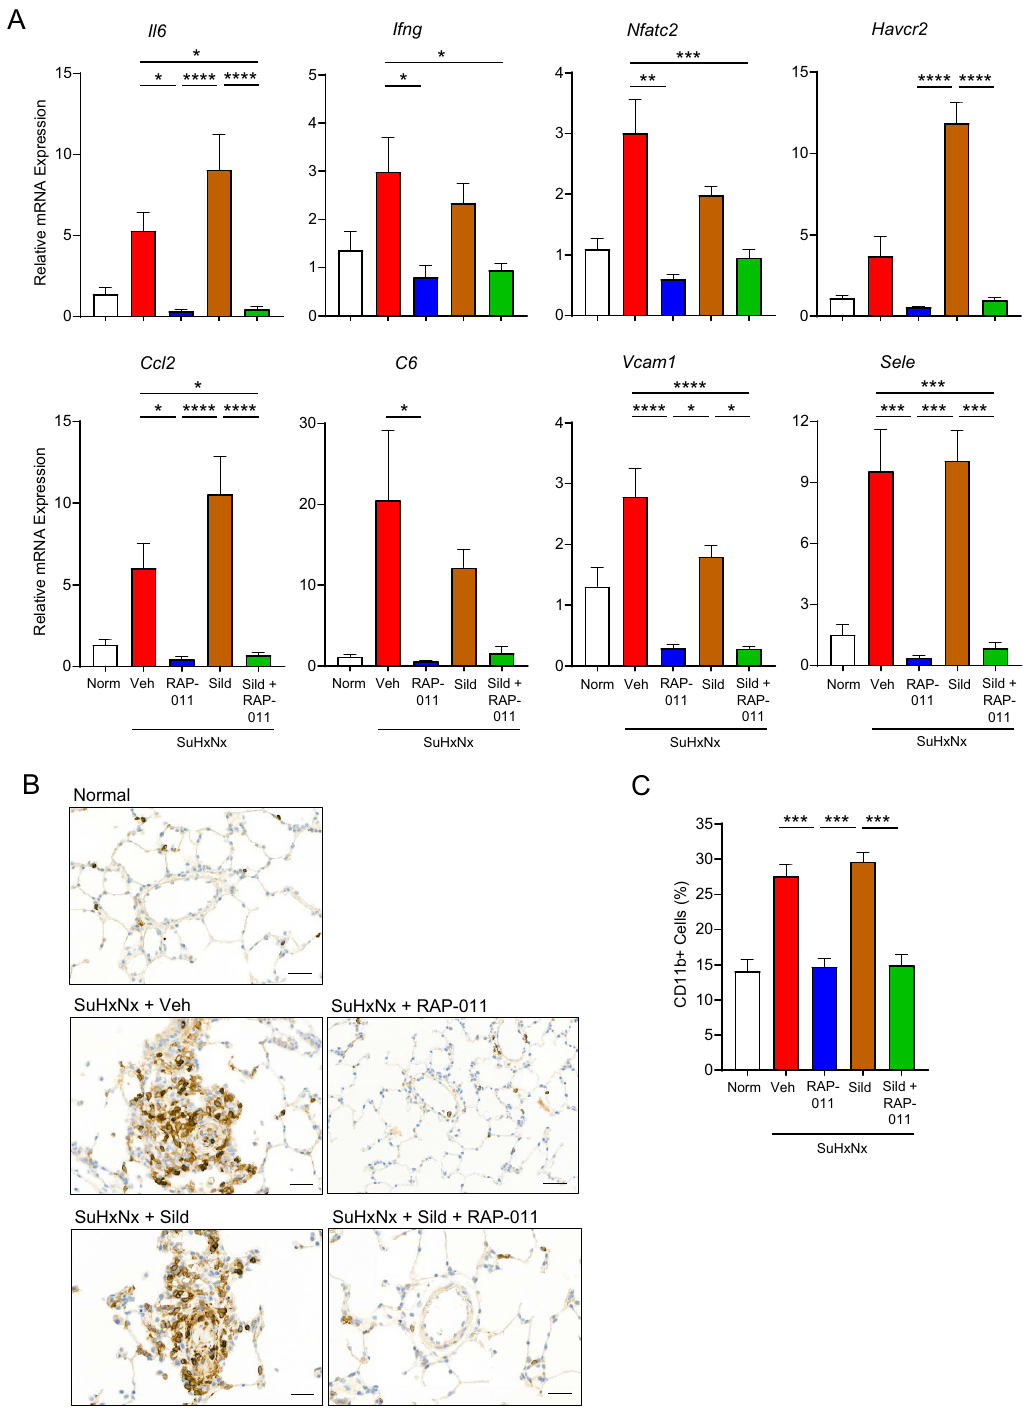
Figure 2. Therapeutic treatment with ActRIIA-Fc suppresses pulmonary inflammation and aberrant immune responses in severe experimental PAH. ( A ) Levels of Il6 , Ifng , Nfatc2 , Havcr2 , Ccl2 , C6 , Vcam1 , and Sele mRNA in lung of normal rats (Norm) or SuHxNx rats treated with vehicle (Veh), RAP-011, sildenafil (Sild), or a combination of sildenafil and RAP-011. Data are means ± SEM (n = 6–9 rats per group). ( B ) Representative images of lung sections immunostained for macrophage marker CD11b revealing prominent clusters of labeled perivascular cells in severe experimental PAH after treatment with vehicle or sildenafil but not RAP-011. ( C ) Quantification of CD11b-positive cells in lung based on assessment of 40 high-magnification fields per rat. Scale bar, 50 µm. Data are means ± SEM (n = 6–9 rats per group). Analysis by one-way ANOVA and Tukey post hoc test (* P < 0.05, ** P < 0.01, *** P < 0.001, **** P <